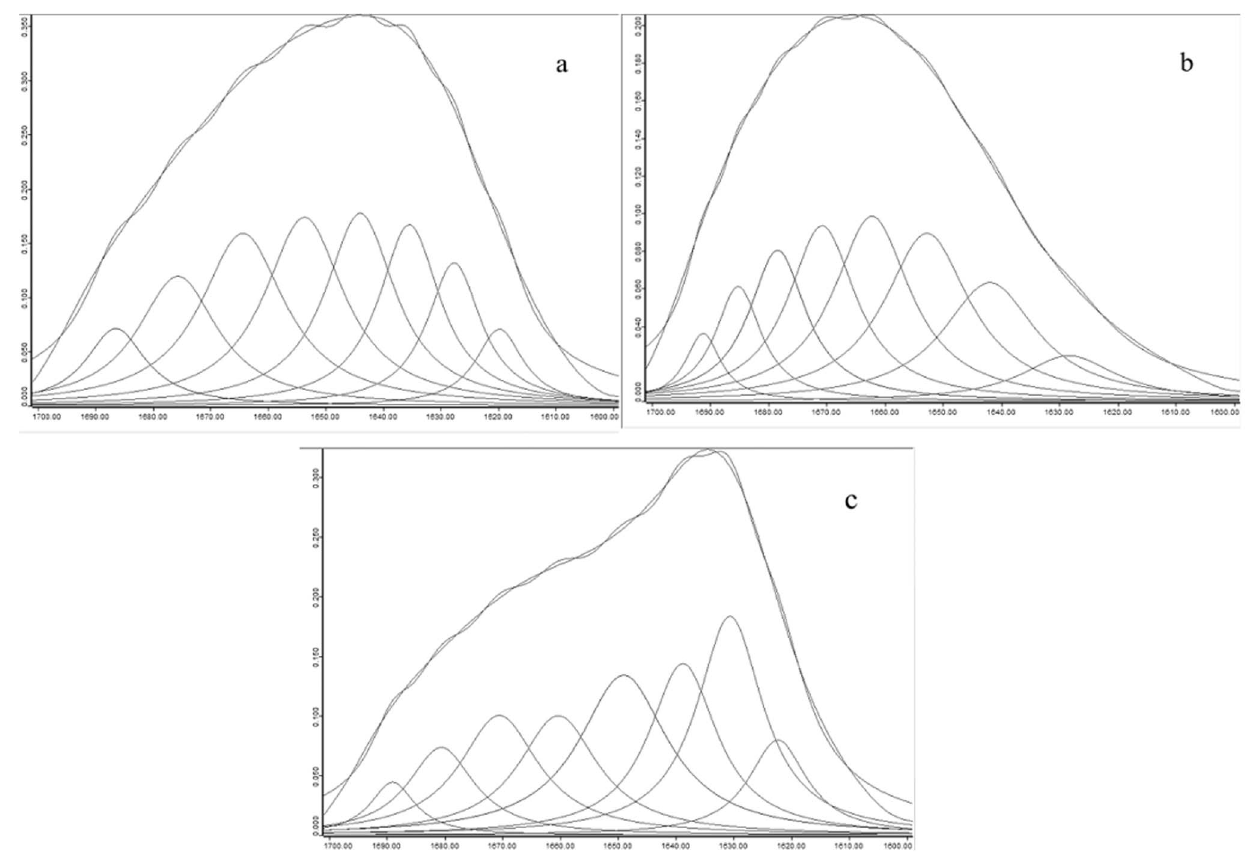
Figure 6. Infrared spectra of the amide I band with curve fitting before and after aggregation. a) WPI. b) WPH. C) Aggregates.